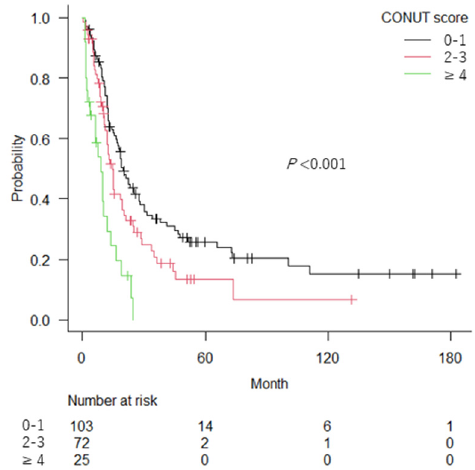
Figure 1. Kaplan–Meier curves for overall survival in patients with advanced urothelial carcinoma according to the controlling nutritional status (CONUT) score.